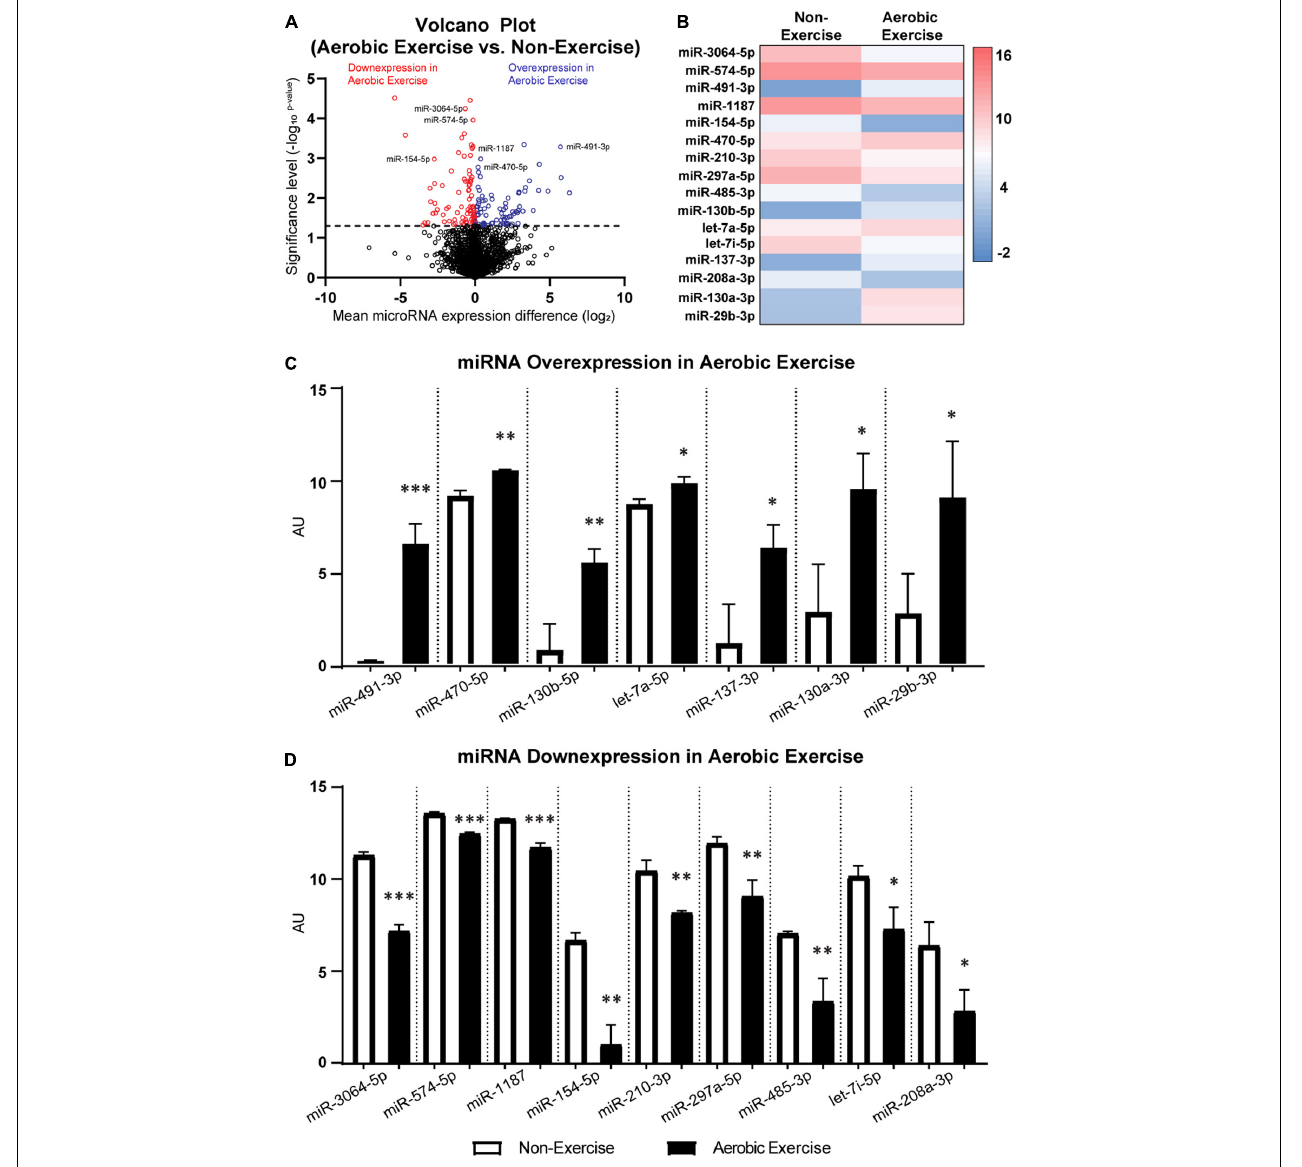
FIGURE 4 | MicroRNA differentially expressed in femora of 4-month-old male BALB/c mice following 8 weeks of aerobic exercise training. Volcano plot of differentially expressed miRNAs with- and without aerobic exercise training (A) . 191 out of 1,900 miRNAs showed statistically significant expression differences between non-exercise and aerobic exercise (above the dotted line). Altogether 91 out of 191 miRNAs had increased expression (blue color), while 100 miRNAs showed decreased expression following aerobic exercise (red color). Particularly, miRNAs that are associated with bone and nerve were differentially expressed in femora following aerobic exercise (B) . Over-expressed miRNAs (C) and down-expressed miRNAs (D) following aerobic exercise training are depicted. See Supplementary Tables 2, 3 for the predictive actions of miRNAs. N = 3 per group. Values are means ± S.D. ∗ p < 0.05, ∗∗ p < 0.01, and ∗∗∗ p <